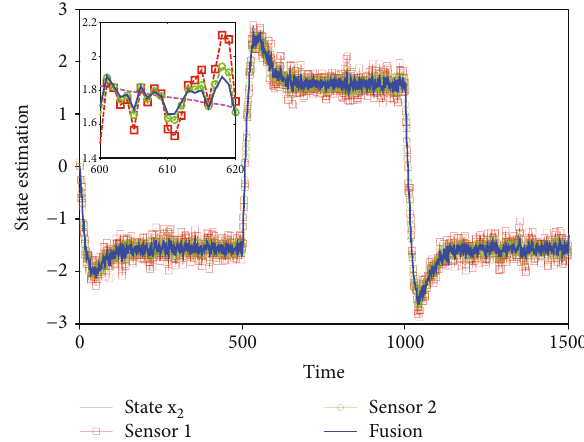
Figure 11: The estimation of x ( L =50).